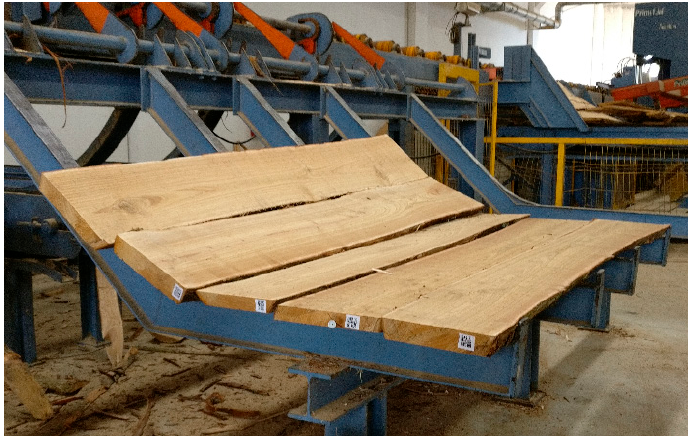
Figure 7. Chestnut boards obtained and marked with QR code at the sawmill.